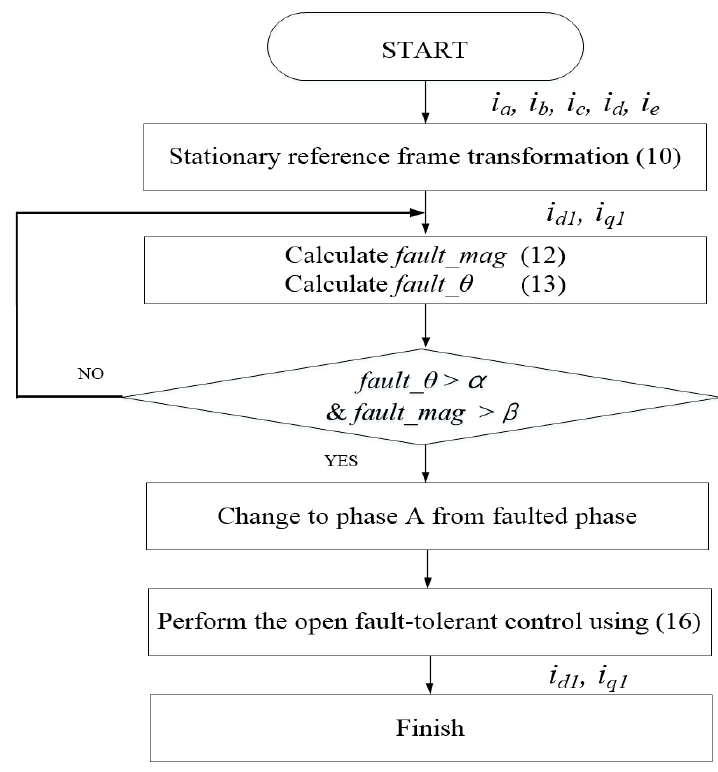
Figure 6. Flow chart for fault detection and fault ‐ tolerant control under arbitrary phase open fault.